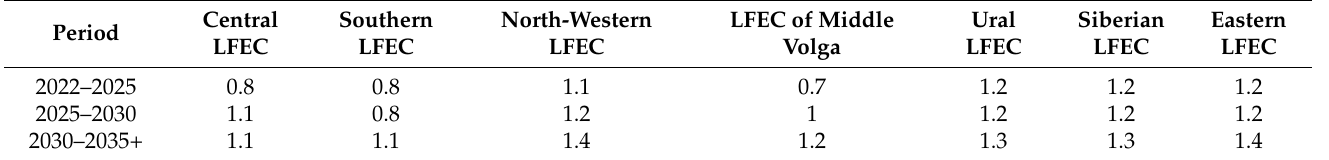
Table 5. Normalized results of the survey for sustainability property (T 1 ) in the gas industry.